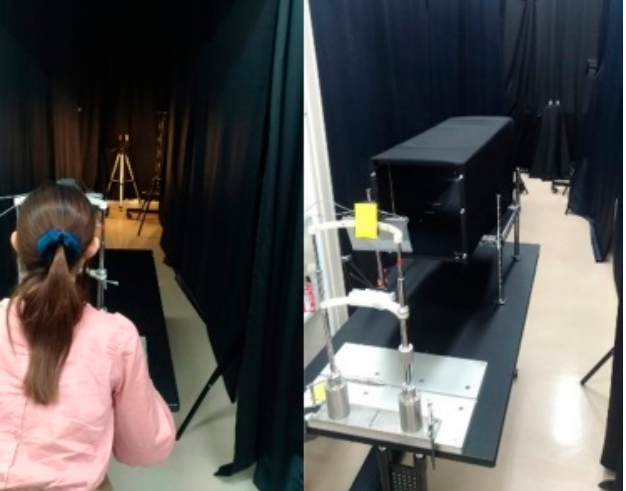
Figure 2. Experimental scene. The sunset environment is recreated by covering the participants’ surroundings with a blackout curtain.